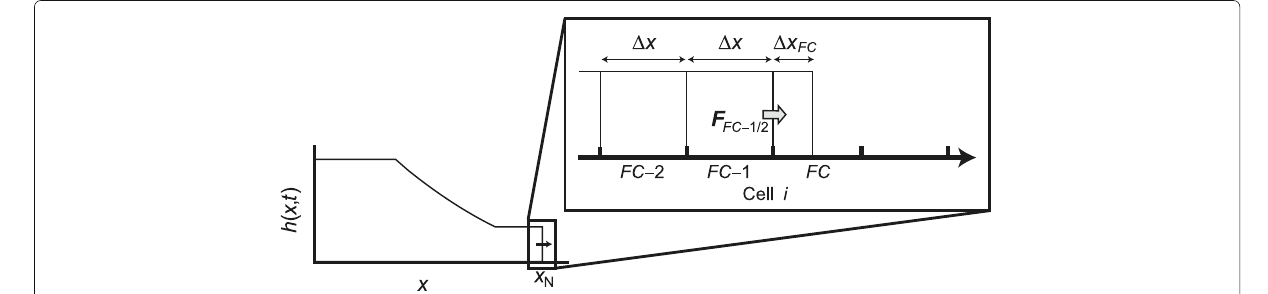
Fig. 4 Schematic of the computational domain of the BC model